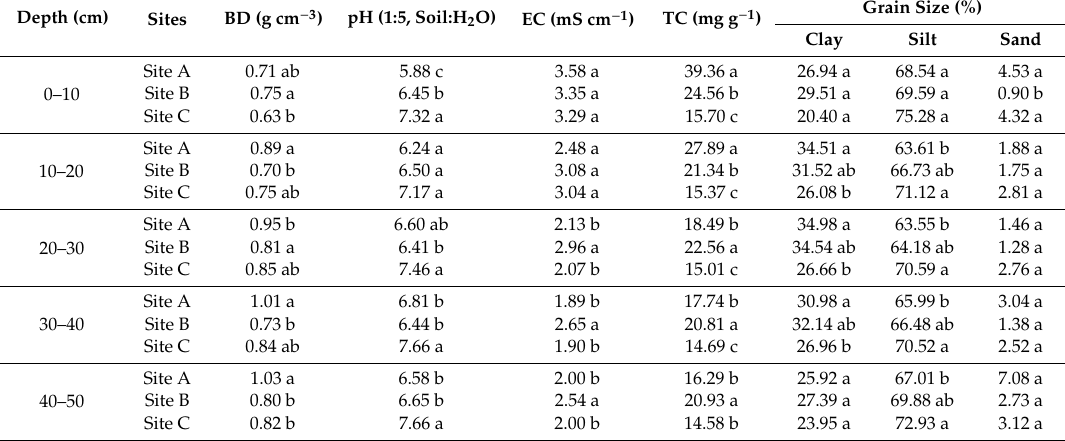
Table 2. Bulk density (BD), pH, electrical conductivity (EC), total carbon (TC), and grain size at each site along the in situ hydrological gradients.